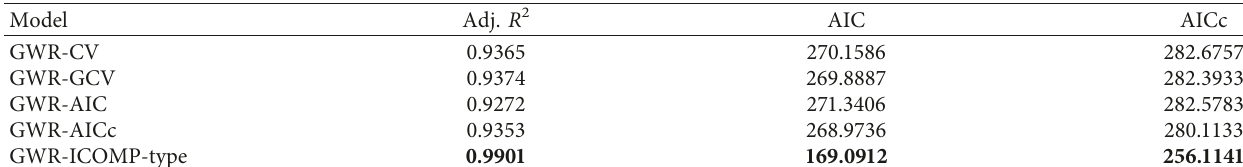
Table 2: Model performance evaluation.